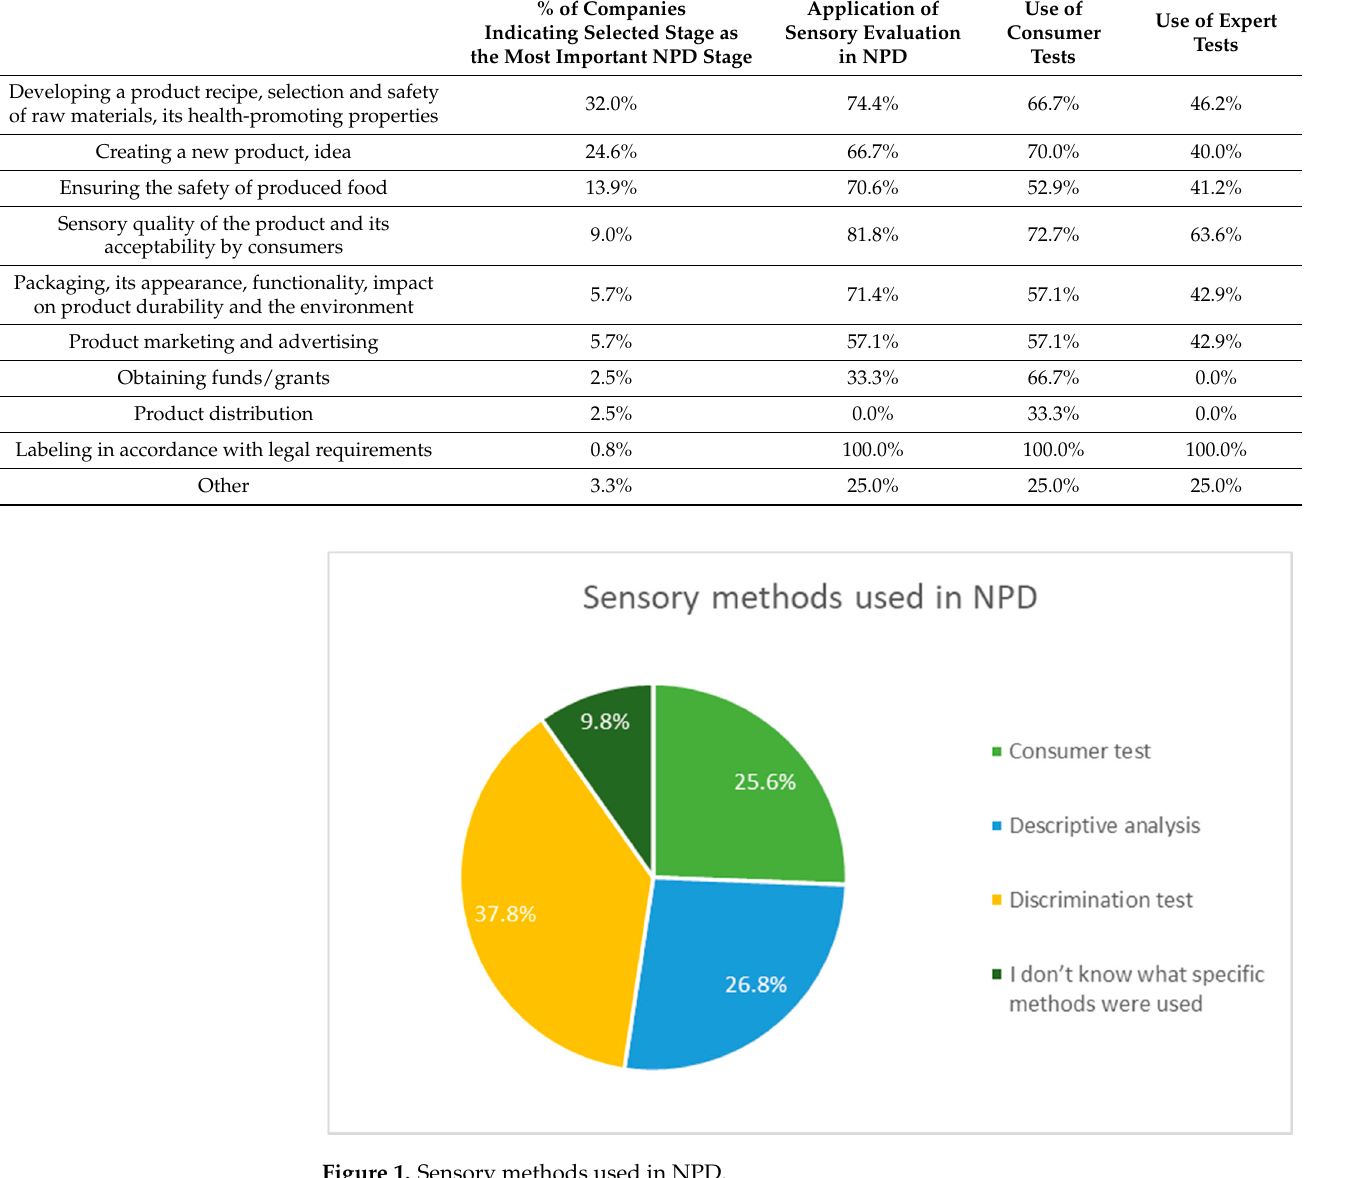
Table 7. Most important stages of NPD and use of sensory evaluation.